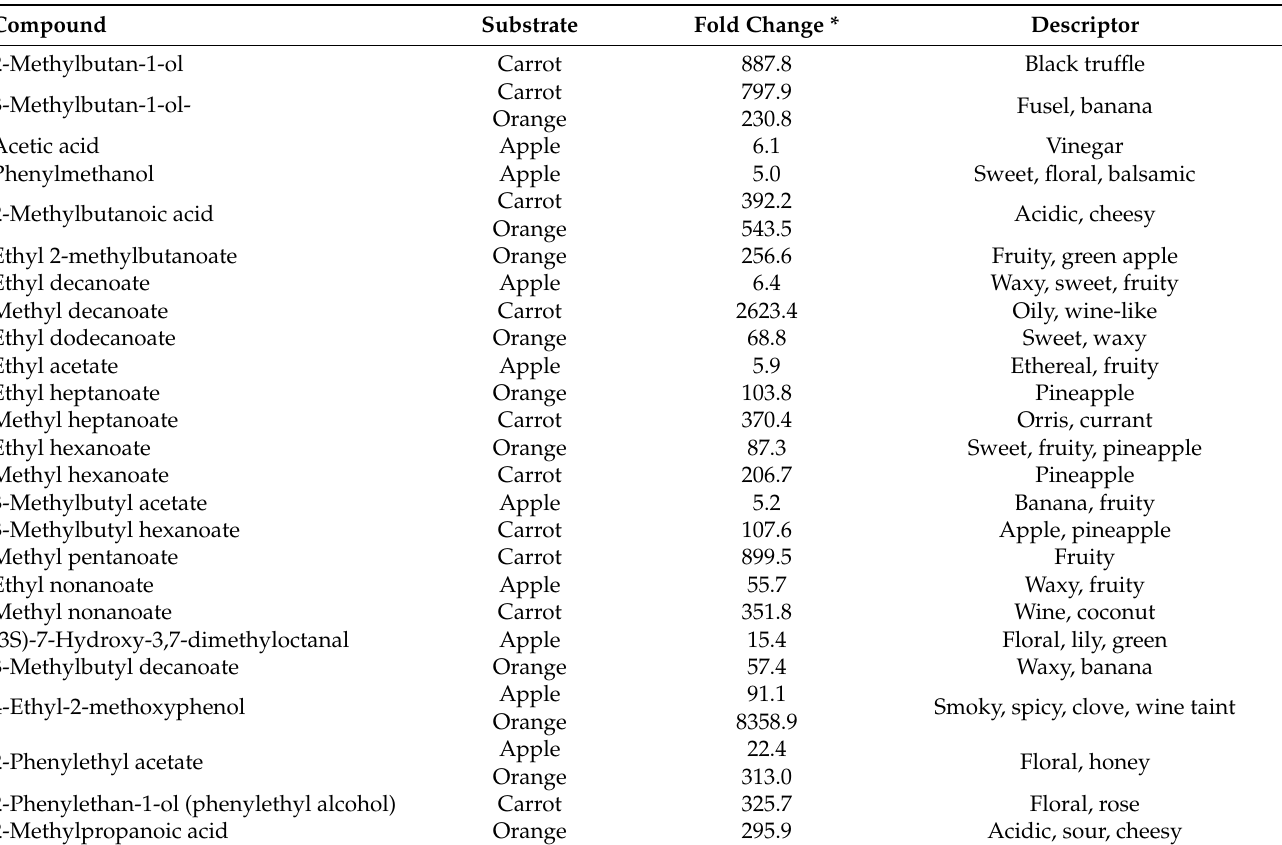
Table 2. Organoleptic qualities of potentially industrially relevant volatile metabolites produced during submerged fermentations of three fruit and vegetable by-products using Brettanomyces bruxellensis .